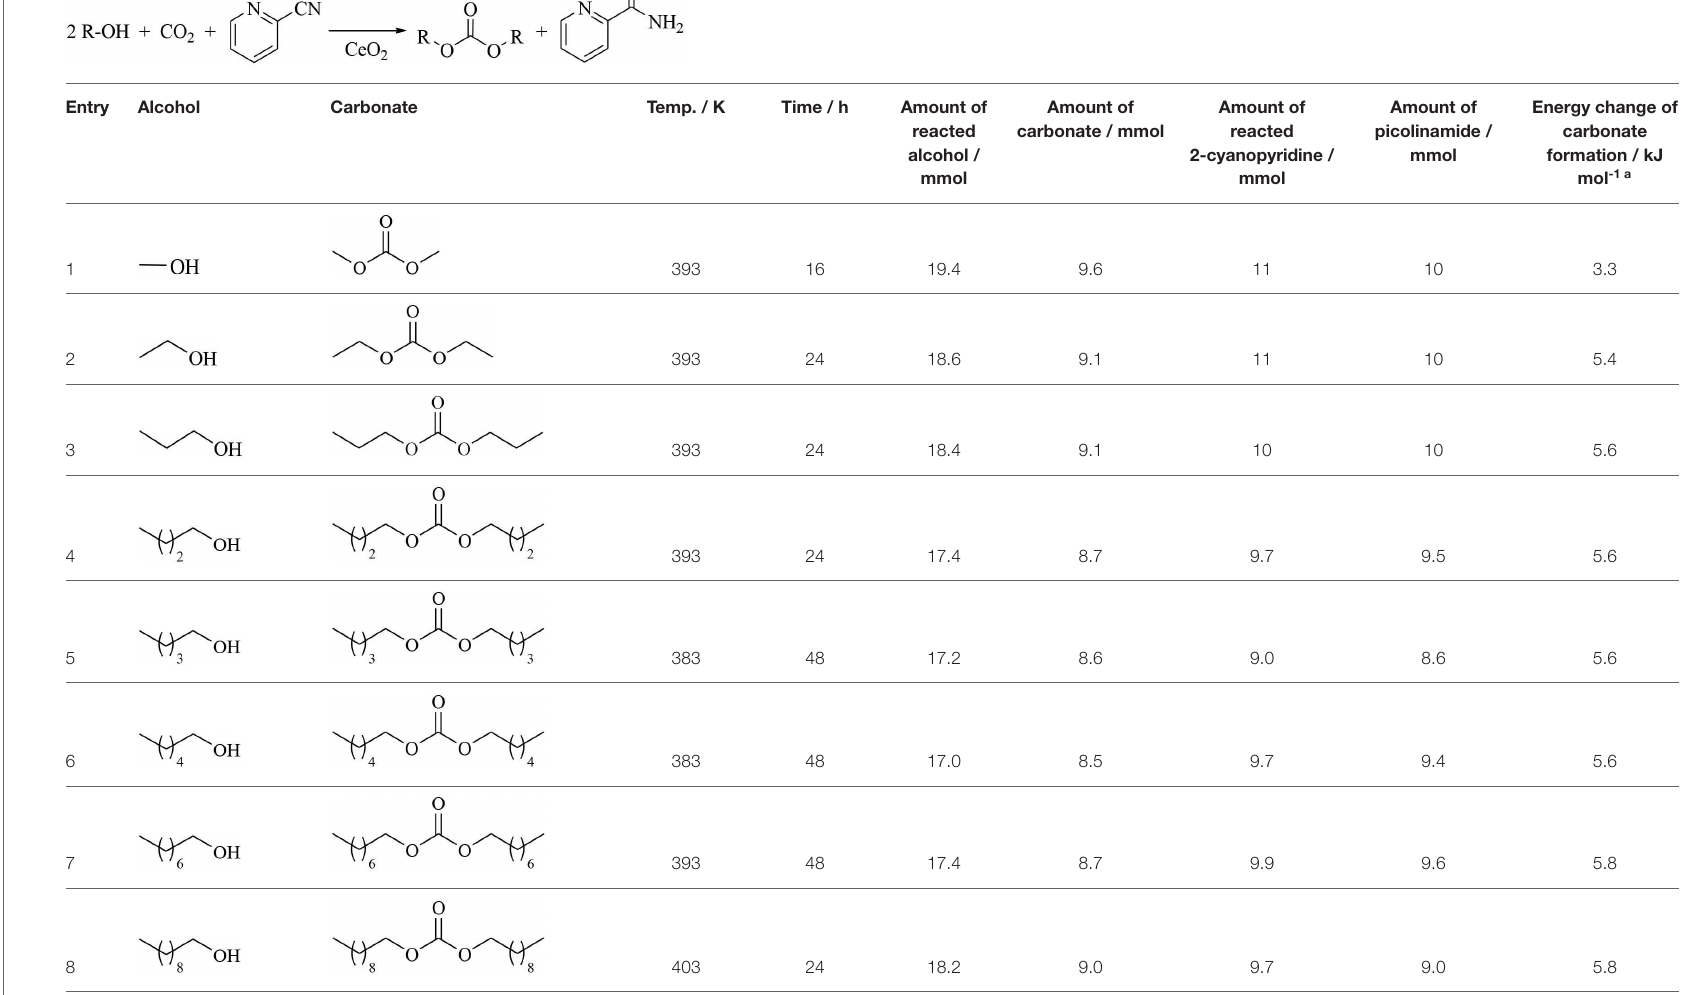
TABLE 5 | Synthesis of linear carbonates from CO 2 and corresponding monoalcohols using CeO 2 and 2-cyanopyridine (Honda et al., 2014c).